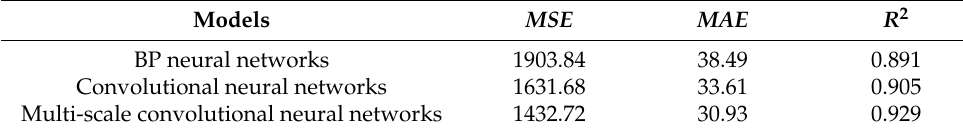
Table 3. Test results of each model.